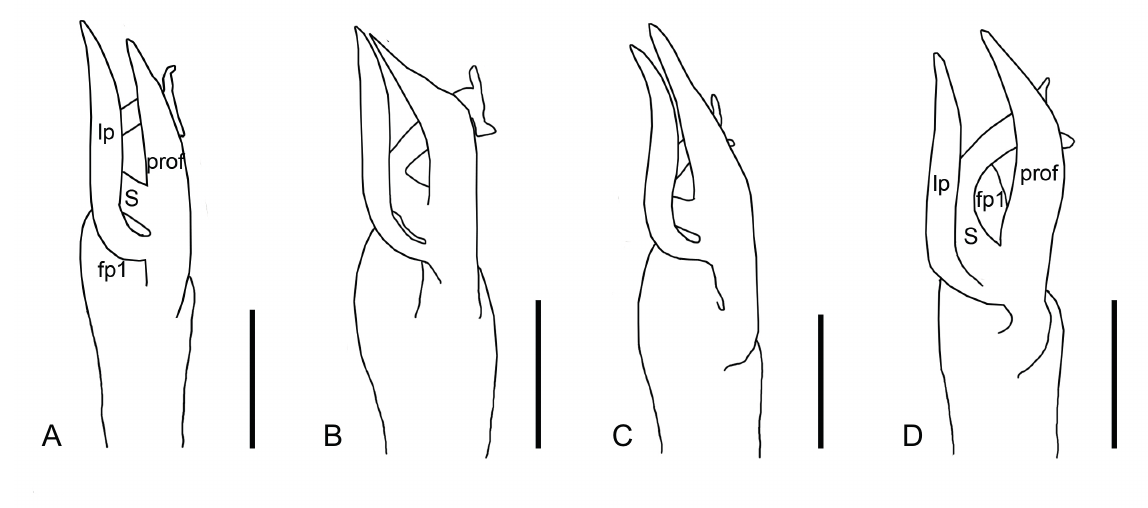
Fig. 20. Pogonosternum jeekeli Decker, sp. nov., ♂, right gonopod, posterior view. A . NMV K-12178, holotype from Warby-Ovens National Park, Devenish-Wangaratta Road. B . NMV K-12195 from Cabbage Tree Palms Flora Reserve. C . NMV K-12197 from Buchan Caves Reserve. D . SMNG VNR016986 from Waterhouse Conservation Area. Scale bars: 0.5